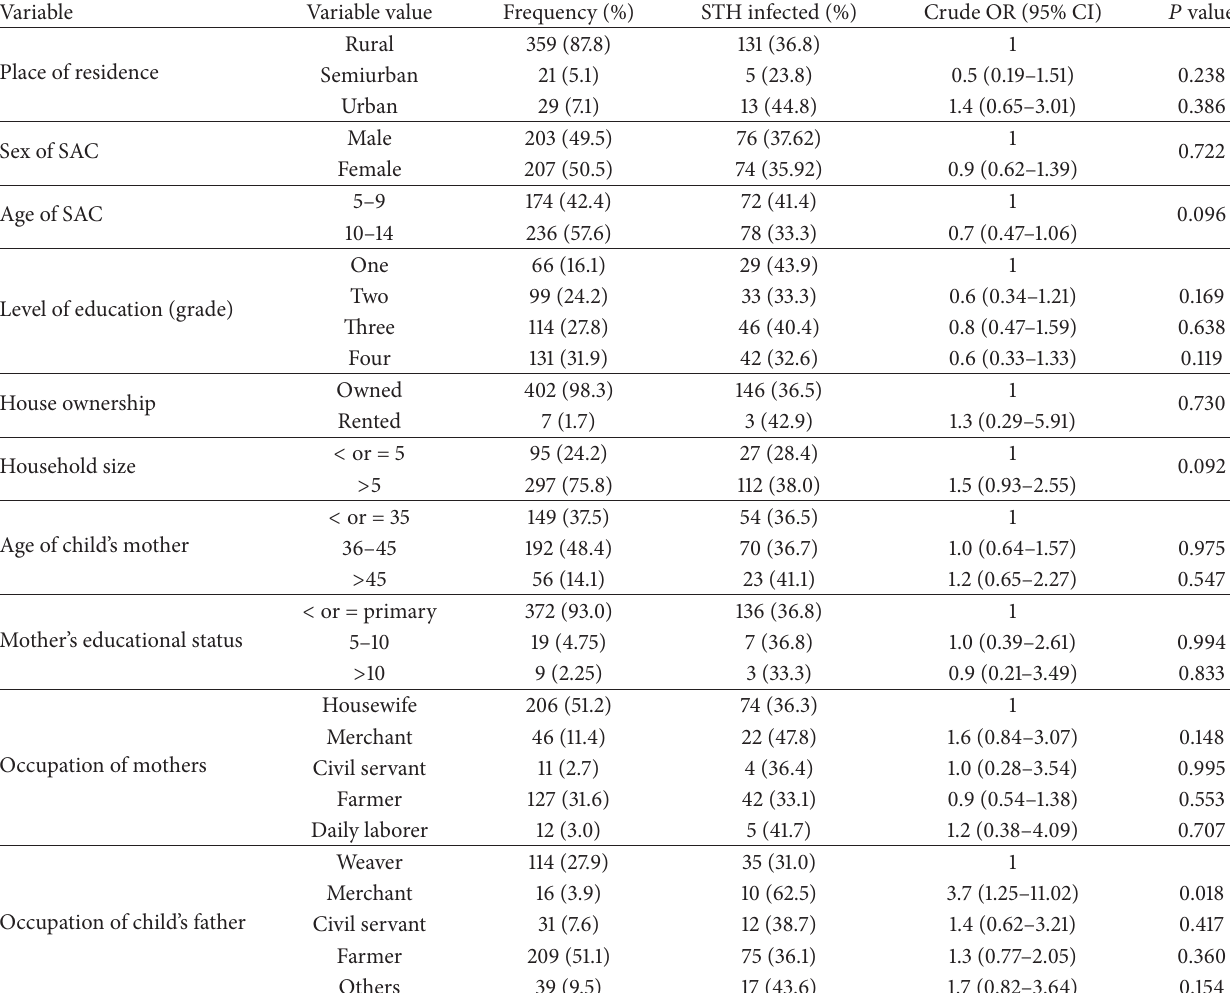
Table 2: Univariate logistic regression of school-age children’s sociodemographic factors and any of the three STH infections in Chencha district, southern